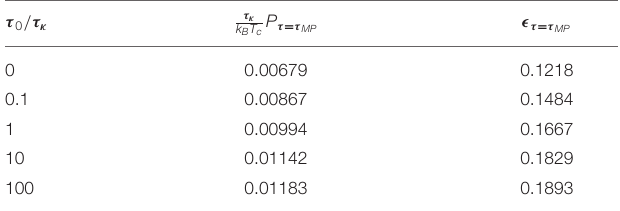
TABLE 1 | Mean power output produced by a Brownian Stirling engine during a τ MP cycle τ 18.6 τ κ and corresponding efficiency for distinct values of the fluid = = relaxation time τ 0